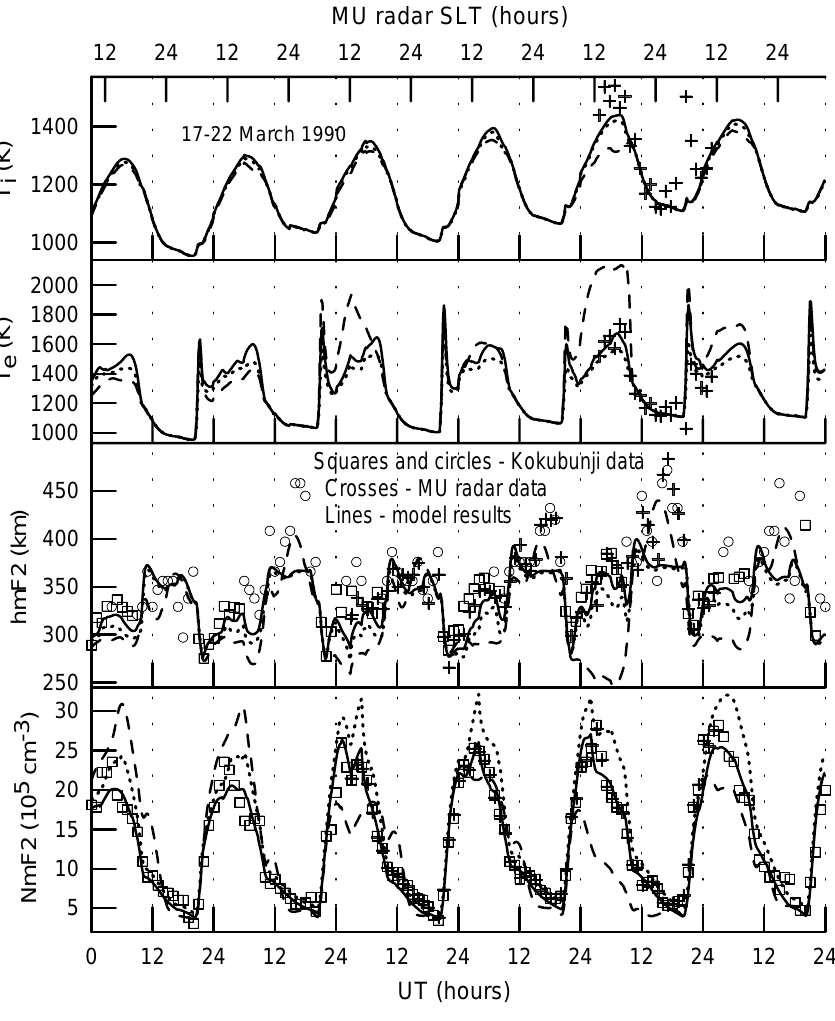
Fig. 6. Observed (crosses) and calculated (lines) Nm F2 and hm F2 (two lower panels), and electron and O + ion temperatures (two upper panels) at the F2-region main peak altitude above the MU radar during 17–22 March 1990. Squares and circles in the two lower panels show Nm F2 and hm F2 measured by the Kokubunji ionosonde. The relations between hm F2 and the measured values of M(3000)F2, fo f2, and fo E (see Sect. 3) are used to determine the values of hm F2, when the measured values of fo E are acceptable (squares) and not acceptable (circles). The curves are the same as in Fig. 3.